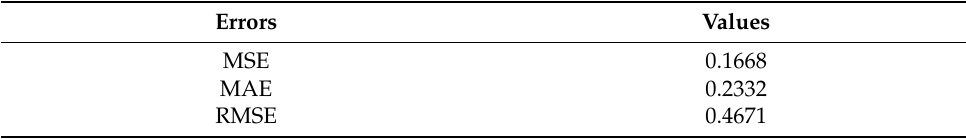
Table 12. Errors of solar radiation prediction using ARMA (2,1).